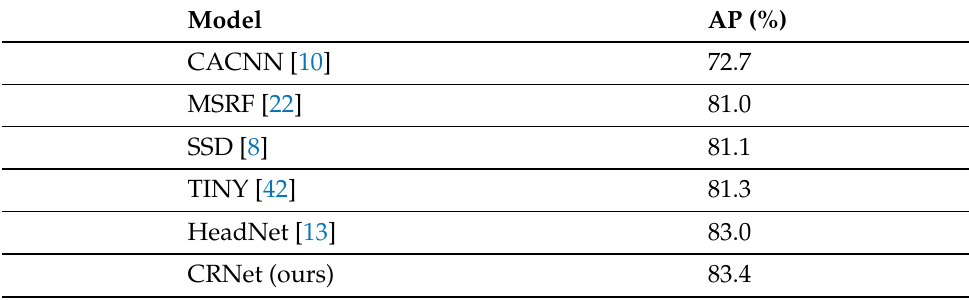
Figure 6. The qualitative results of our method on the Brainwash dataset. We present the results of four different methods. Red boxes indicate the missed heads, while yellow boxes represent samples for error detection, and green boxes are detection results that match the ground truth. Table 5. The results on the HollywoodHeads